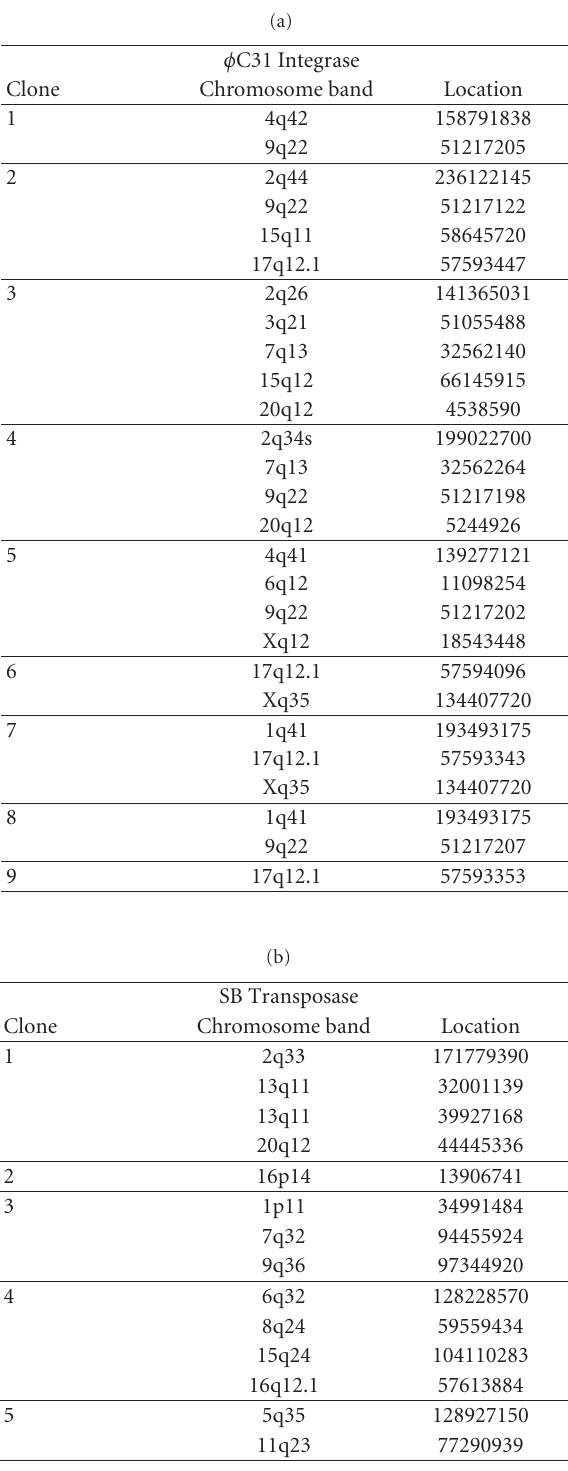
Table 2: φ C31 and SB chromosome junction sequences recovered from rat MAPC. Around 10 each of drug-resistant clones obtained with PhiC31 integrase and SB transposase were chosen at random to determine the site of genomic integration. Most clones showed more than one integration event, consistent with southern blot results. Exact genomic locations were determined by comparison of the chromosomal junction sequence with that of the rat genome.